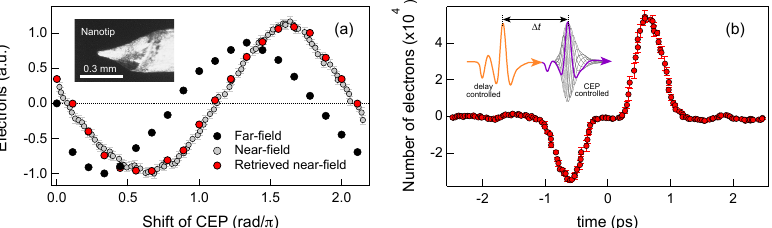
Fig. 2 (a) CEP dependence of rectified electrons induced by single-cycle terahertz pulses (grey circles). Black and red circles are those calculated for THz far-field obtained with EOS and near- field retrieved using an antenna-model that assigns an equivalent RLC circuit to the nanotip, respectively. The inset shows optical micrograph of Pt/Ir nanotip. (b) Number of electrons as a function of delay time between the sinusoidal near-field and the delay-controlled THz waveform. The inset shows schematic of the experimental